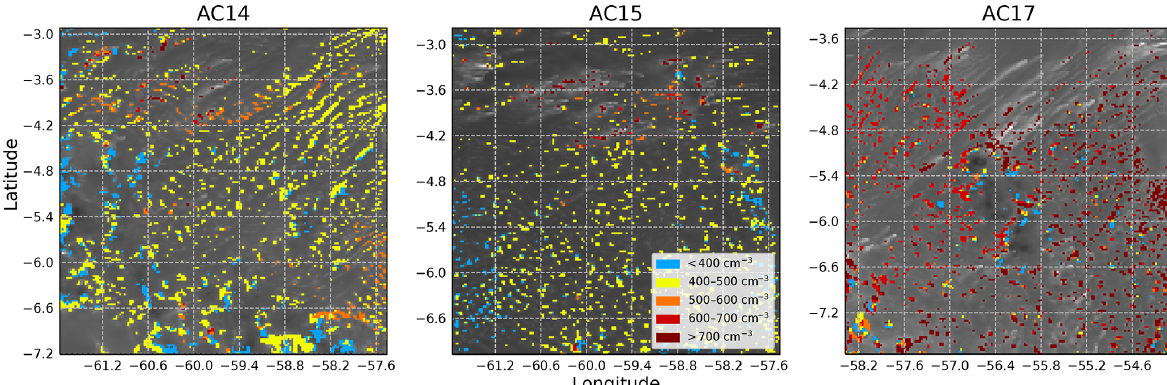
Figure 4. Spatial variability in modeled concentration of CCN at cloud base on 3d (at 18Z) for the entire nested domain. Modeled aerosol optical depth (AOD) is shown as grey shading in the background, with brighter colors indicating higher AOD values. CCN concentrations are only shown where clouds were